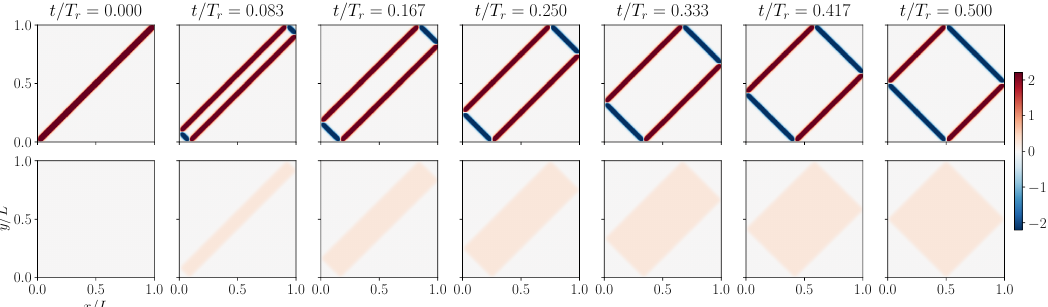
Figure 17: Phase-phase G φφ ( x , y , t ) ( top ) and density-phase G φρ ( x , y , t ) propaga- tors ( bottom ) for a homogeneous box with Neumann boundary conditions (real space density plots at various times from zero to half of the recurrence time).